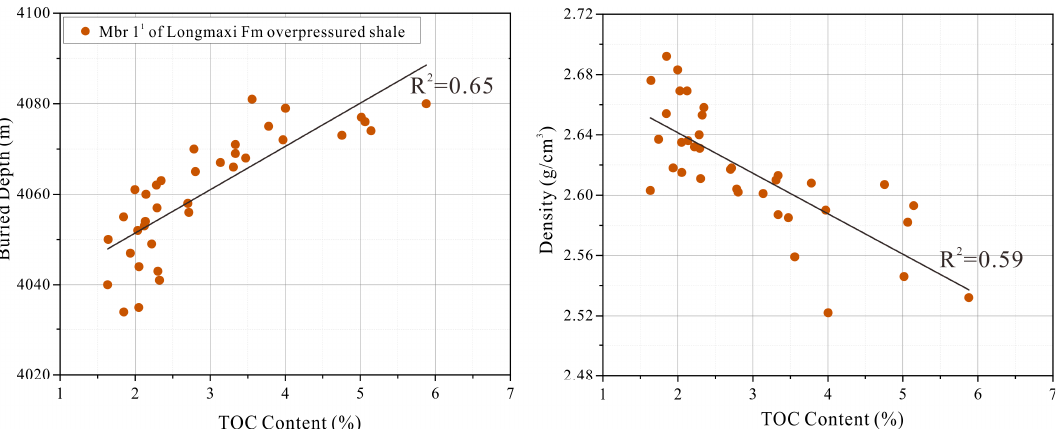
Figure 8. Cross-plots of buried depth and logging density versus TOC content in 4020–4100 m interval of the Mbr 1 1 of Longmaxi Fm shale of Well H-2. The strong correlation between density and organic matter abundance indicates that overpressure and organic matter enrichment control density.